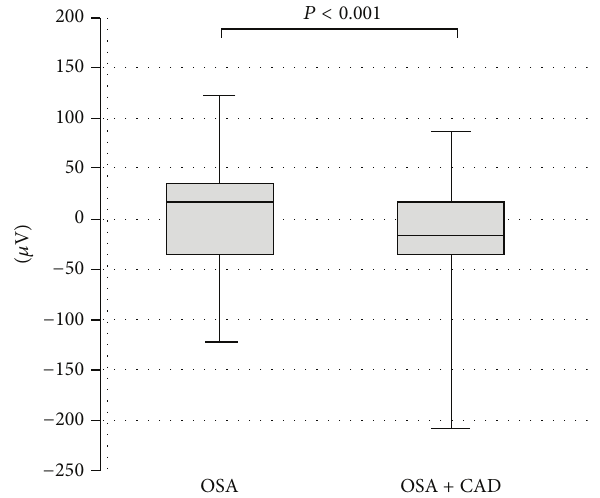
Figure 3: ST segment depression at the time of the deepest oxygen desaturation (CAD: coronary artery disease; OSA: obstructive sleep apnea). Middle horizontal line inside box indicates median. Bottom and top of the box are 25th and 75th percentiles, and the error bars outside the box represent maximum and minimum values,